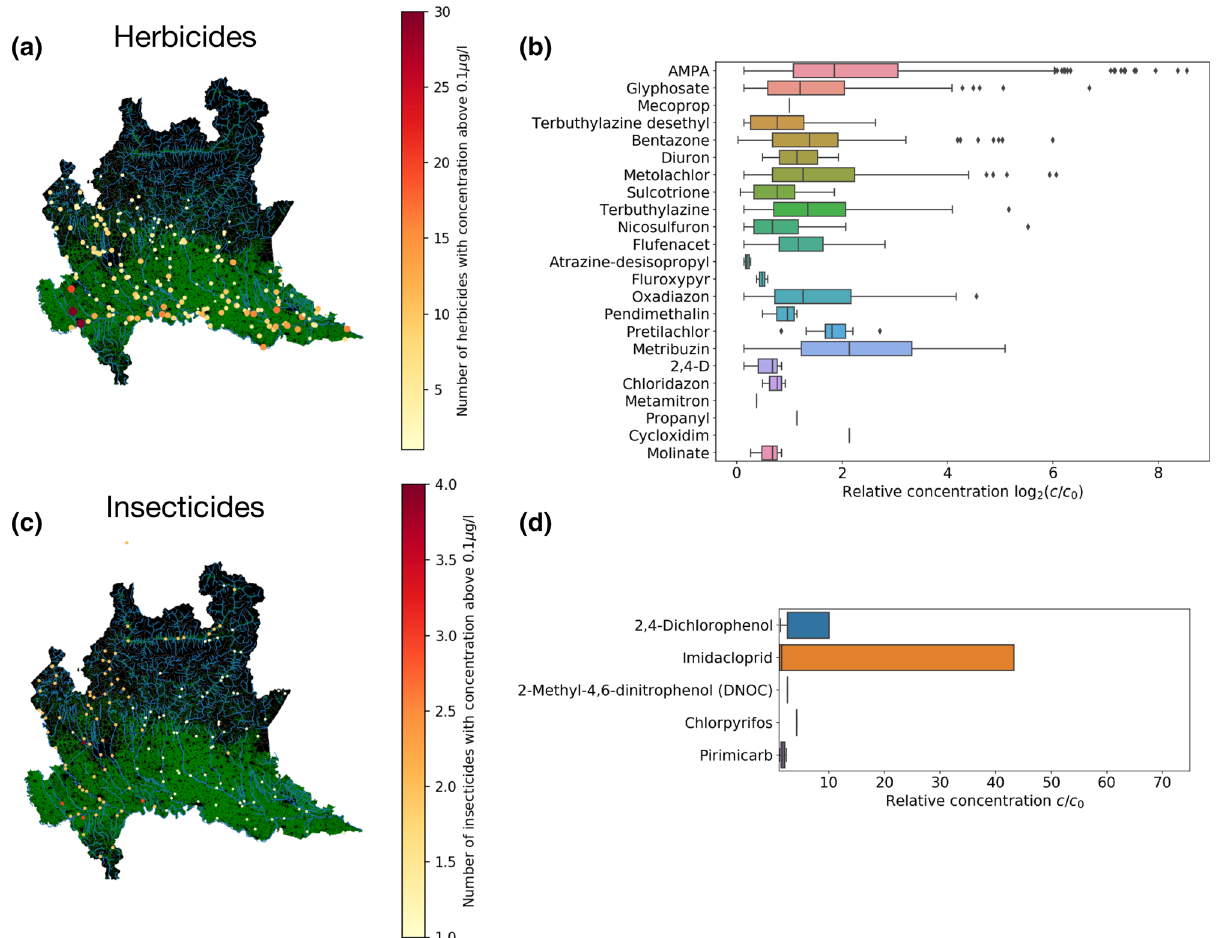
Figure 1. Distribution of herbicides and insecticides in surface waters. ( a ) Map showing where herbicides with c > c 0 = 0.1 μg/l have been recorded. The color code of the markers represents the number of substances found in the same location at the same time. Cultivated areas are colored in green, non cultivated areas are in black and rivers in cyan. ( b ) The distribution of relative concentrations c / c 0 of herbicides (only when c > c 0 ) Error bars in the boxplot are 1.5 of the inter-quartile range. ( c ) Same as ( a ) but for insecticides. ( d ) Same as ( b ) but for insecticides. The map was created in python3.7 using the geopandas (0.6.1) package (https:// geopa ndas.